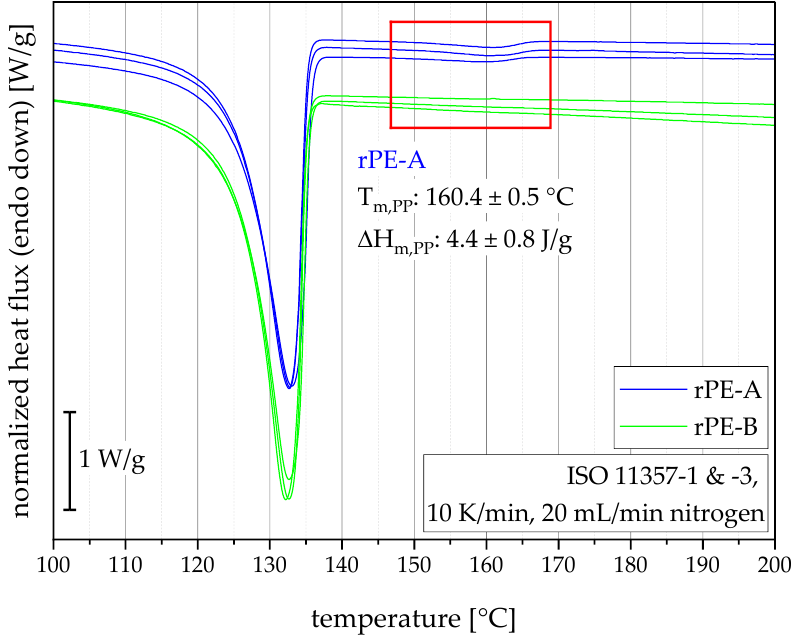
Figure 5. DSC thermograms of three repetition measurements for both recyclates and average values for the PP melting peak, which is framed by the red square, of the PE-HD recyclate